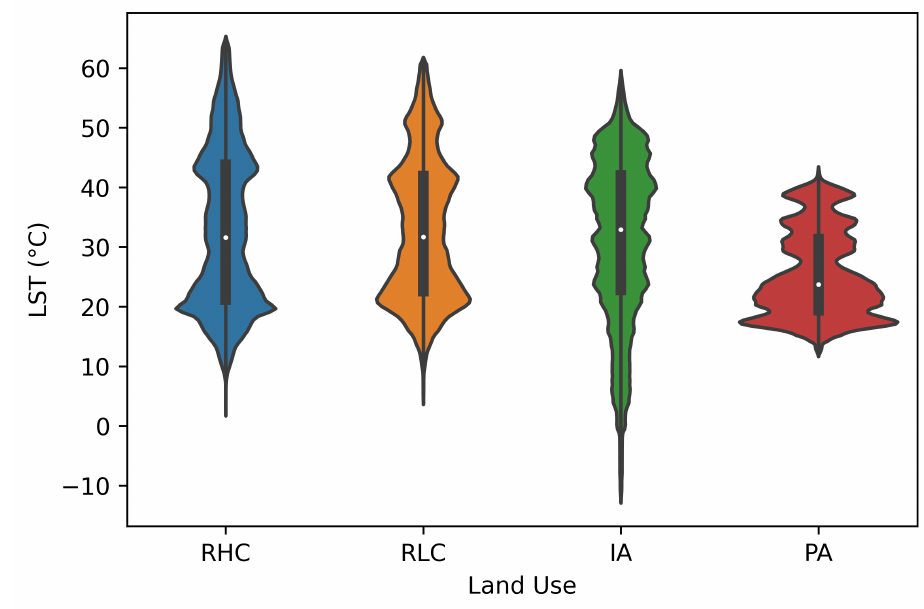
Figure 5. Violin plot showing the distribution of LST for each LU from all eight